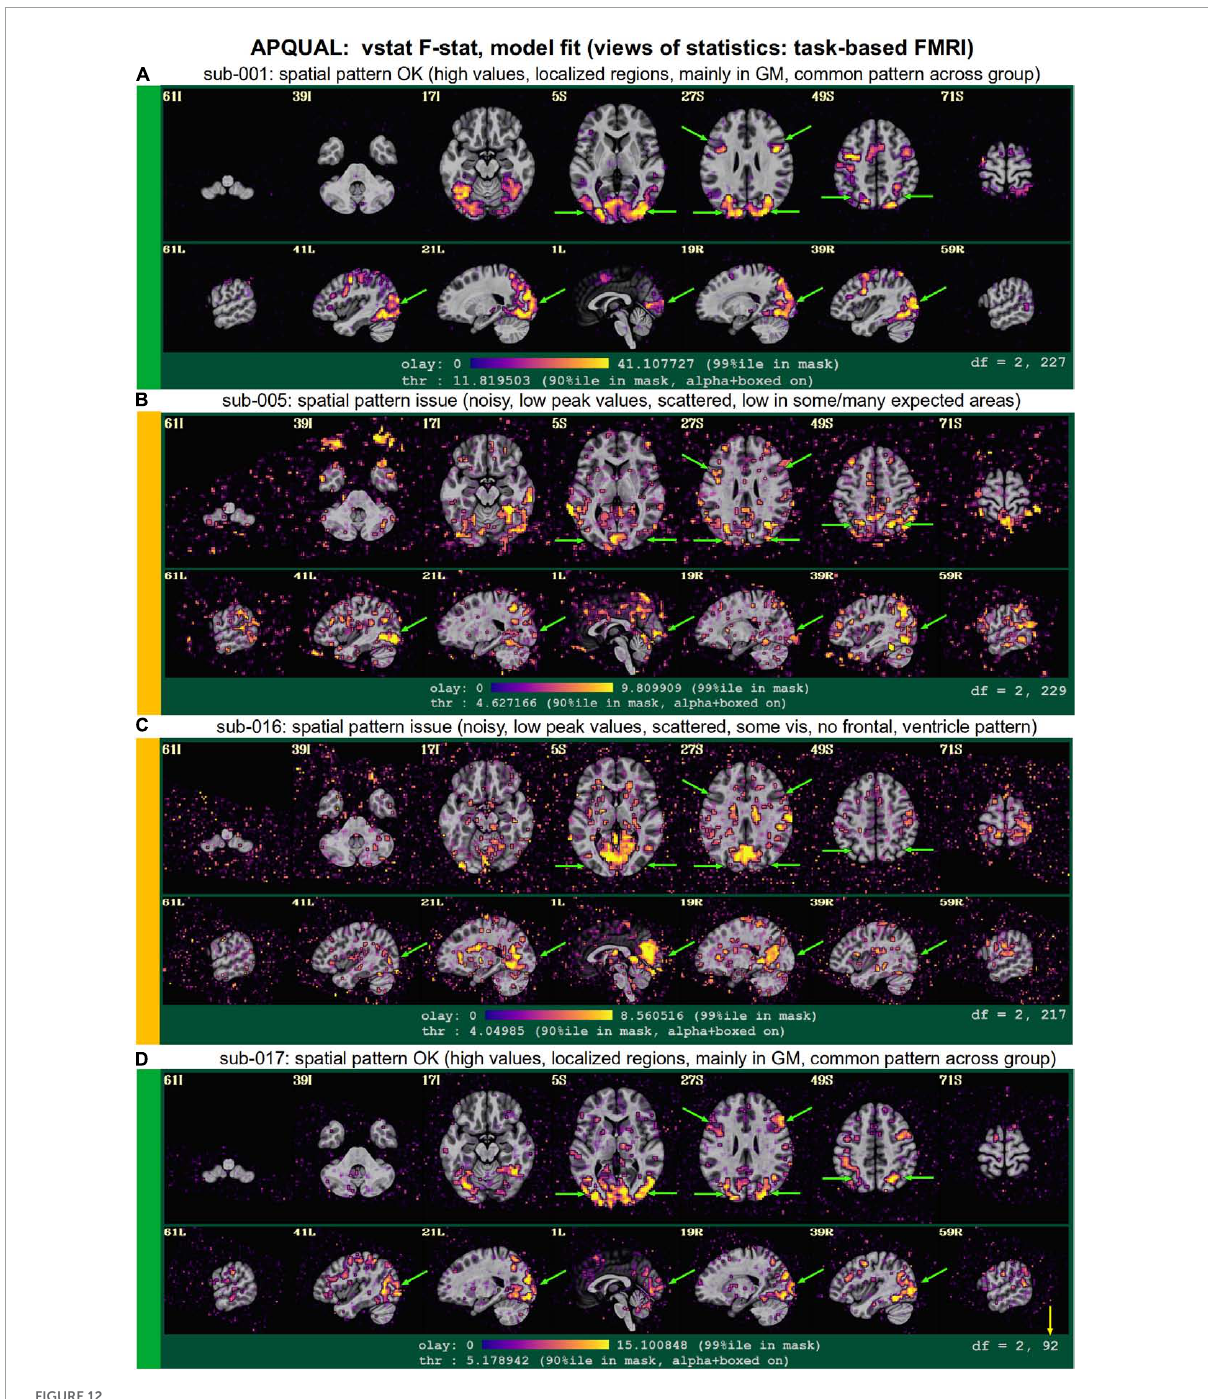
FIGURE12 APQUAL examples for the task-based FMRI group from “vstat” QC block: Visualizations of statistical and modeling information after regression (here, the full F-stat from the regression modeling, highlighting regions of high model fitting). (A) High F-stat values are localized in GM (esp. visual cortex, and perhaps some in expected regions, if background knowledge is present), and this spatial pattern is fairly typical across the group (green arrows). (B) Compared to (A) the F-stat values are much lower (poorer fits) and less localized in GM, including the visual cortex, though the frontal regions in slice Z =27S are observable; scattered noise has relatively high amplitude. (C) Compared to (A) F-stat values are much lower (poor fits) and less localized in GM, though part of the visual cortex is observed clearly; the ventricles have relatively high F-stat. (D) This dataset has similarly reasonable properties as dataset A, even though 57% of its time points were censored due to motion (note the second value in the degree of freedom count, df = 92, is much lower than the other volumes); this subject was still excluded, because of the automatic quantitative (APQUANT)